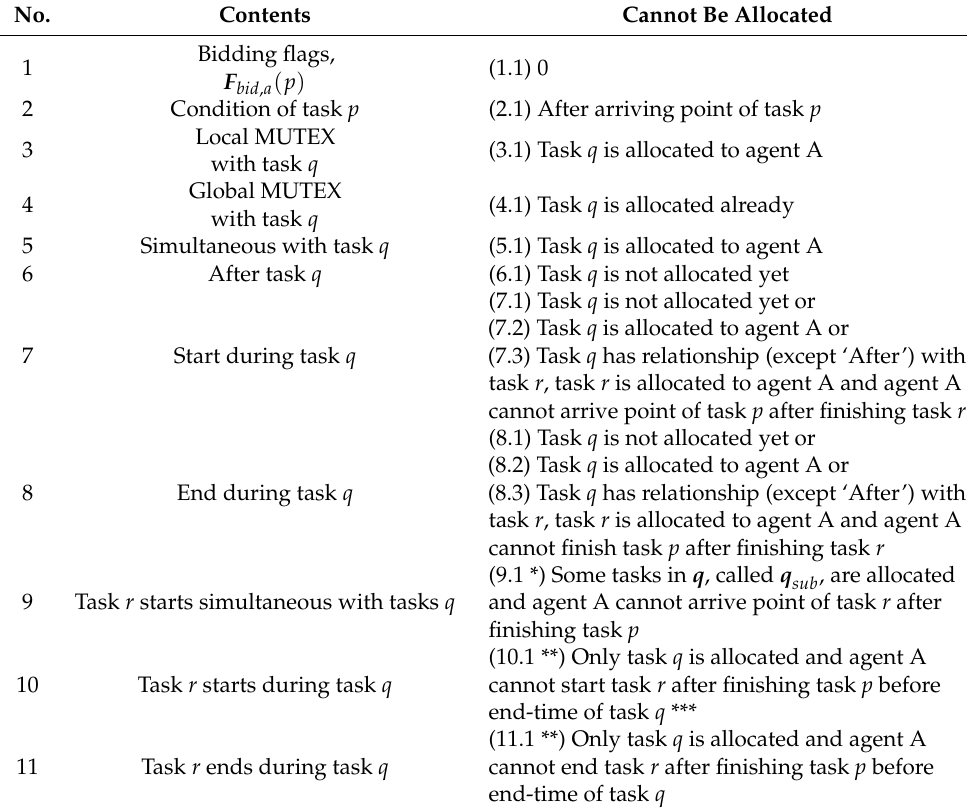
Table 11. Conditions for prohibition of allocating task p to agent A in